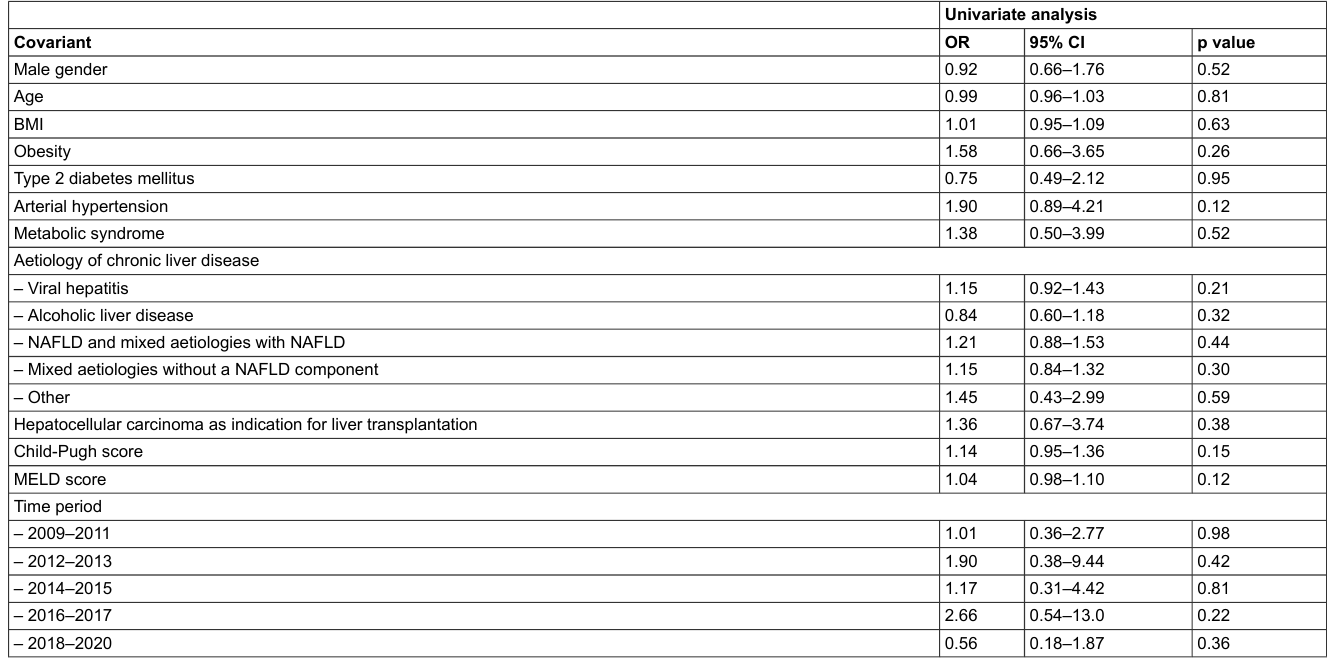
Supplementary table 1: Univariate analysis of variables associated with non-listing.